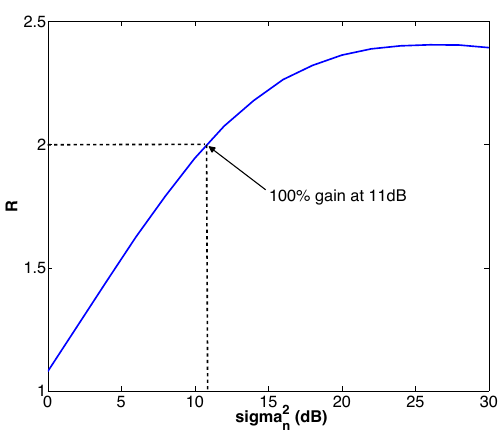
Figure 12. Ratio of sum rate of hybrid scheme over sum rate of TDMA (SISO BC). For SNR values >11dB, the employment of the hybrid scheme provides 100% gain over